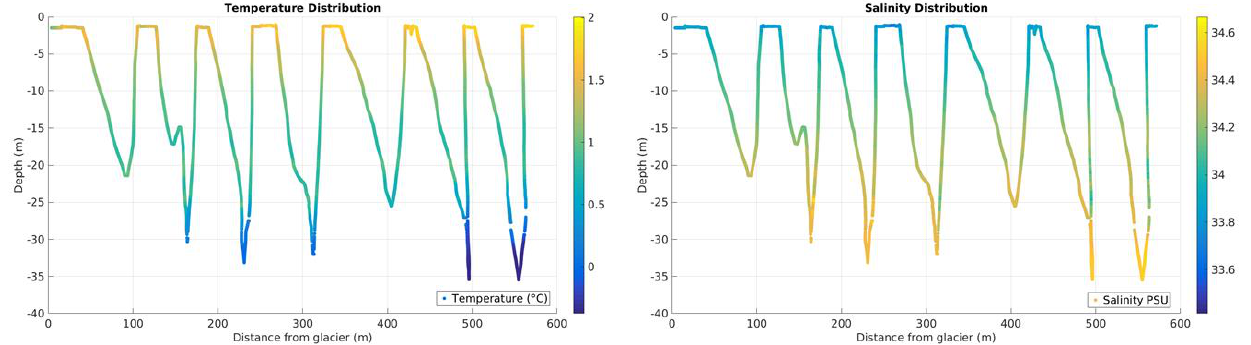
Figure 7. Graphs showing the variation in temperature (°C; yellow = warm; blue = cold; left side) and salinity (PSU; yellow = high salinity; blue = low salinity; right side) as a function of depth (m, y -axis) and distance from the front of the glacier (m, x -axis).